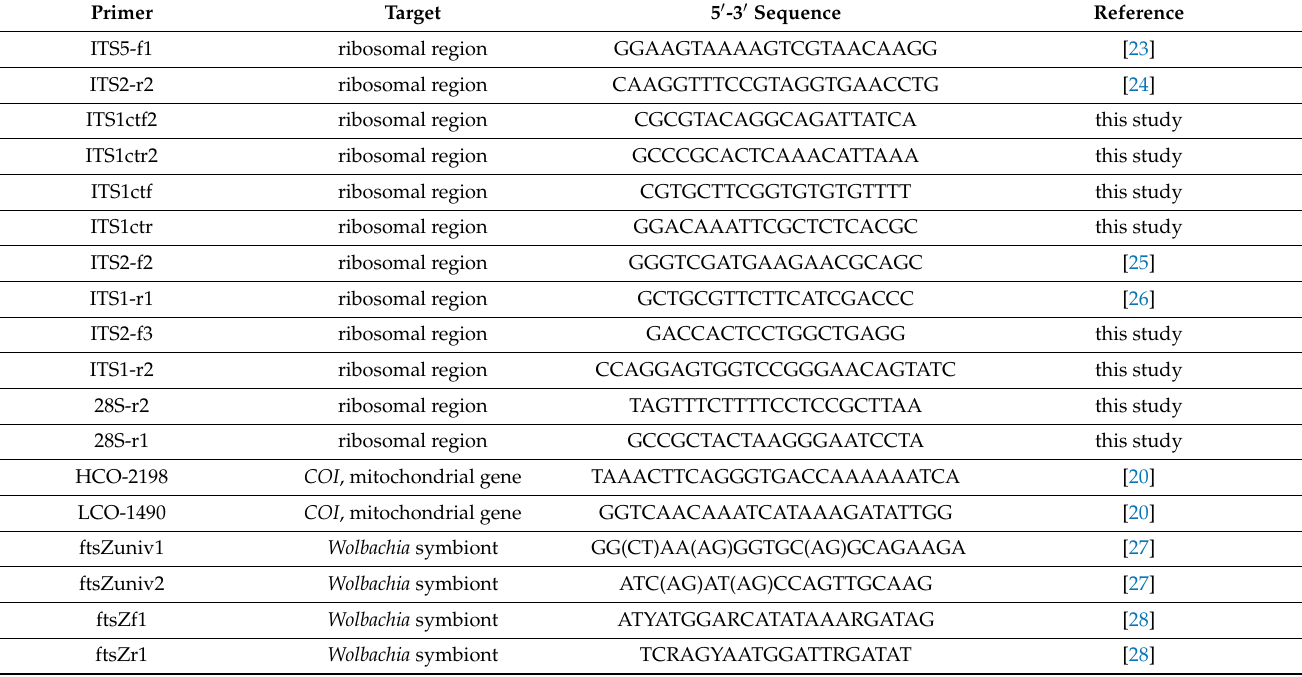
Table 3. Primers used in the